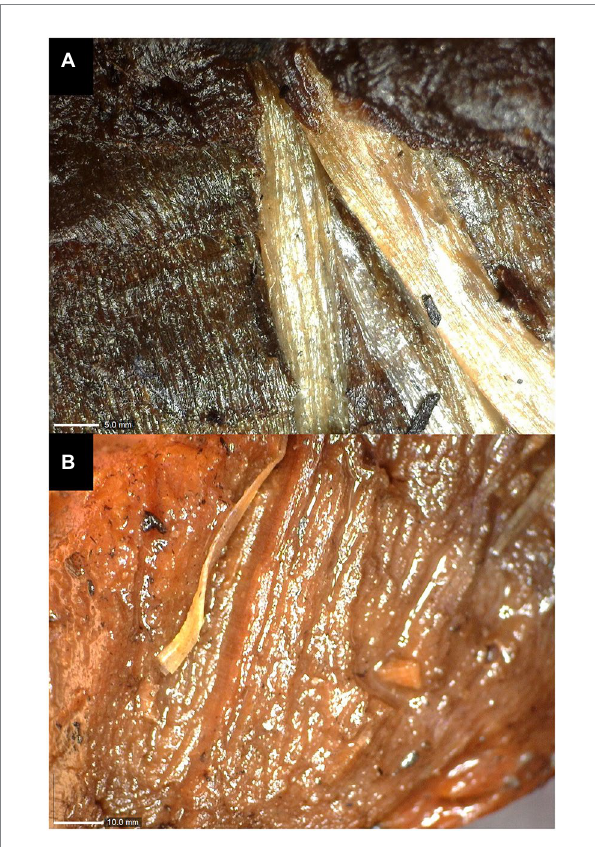
FIGURE 2 Alterations of waterlogged wood visible to the naked eye: (A) leaching of fibers and (B) spongy appearance.